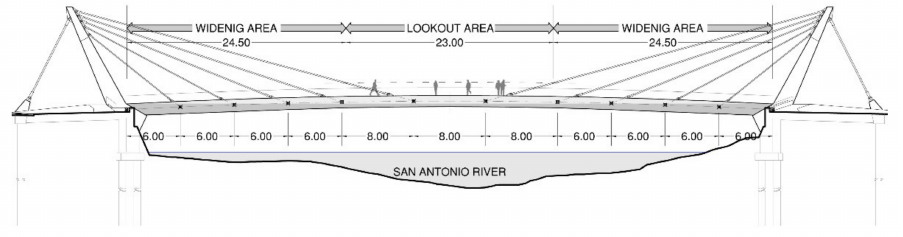
Figure 10. The central lookout area, higher and clear of visual interference for almost a third of the crossing.